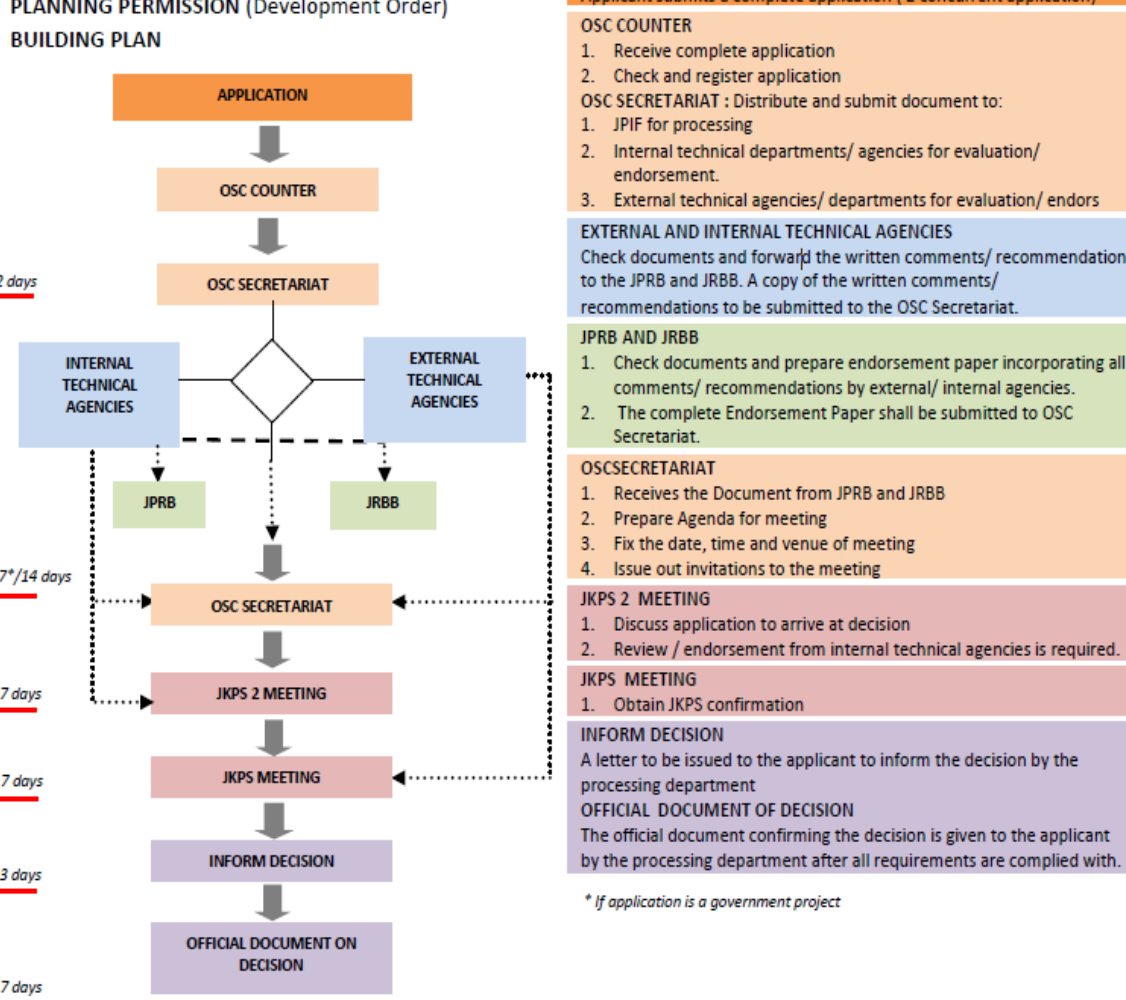
Figure 8: Medium scale planning approval procedure.